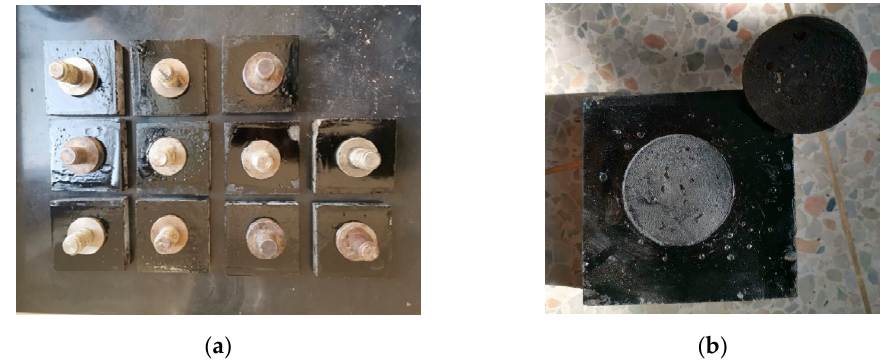
Figure 3. The specimens of tensile adhesion test: ( a ) before the test and ( b ) after the test.